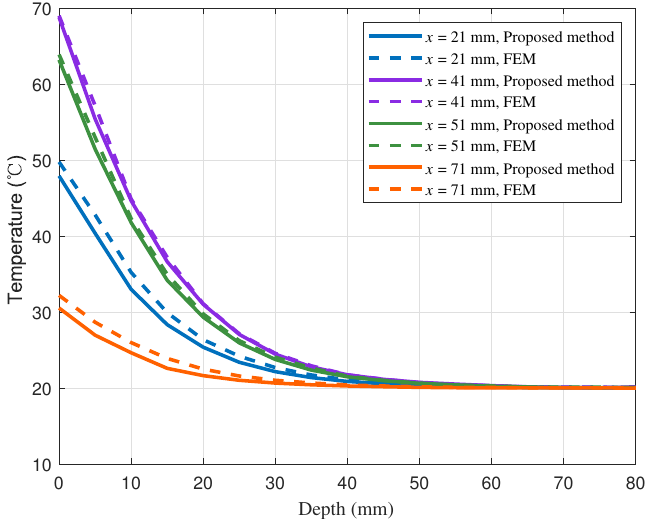
Figure 5. The temperature distribution when x is 21, 41, 51, and 71 mm.